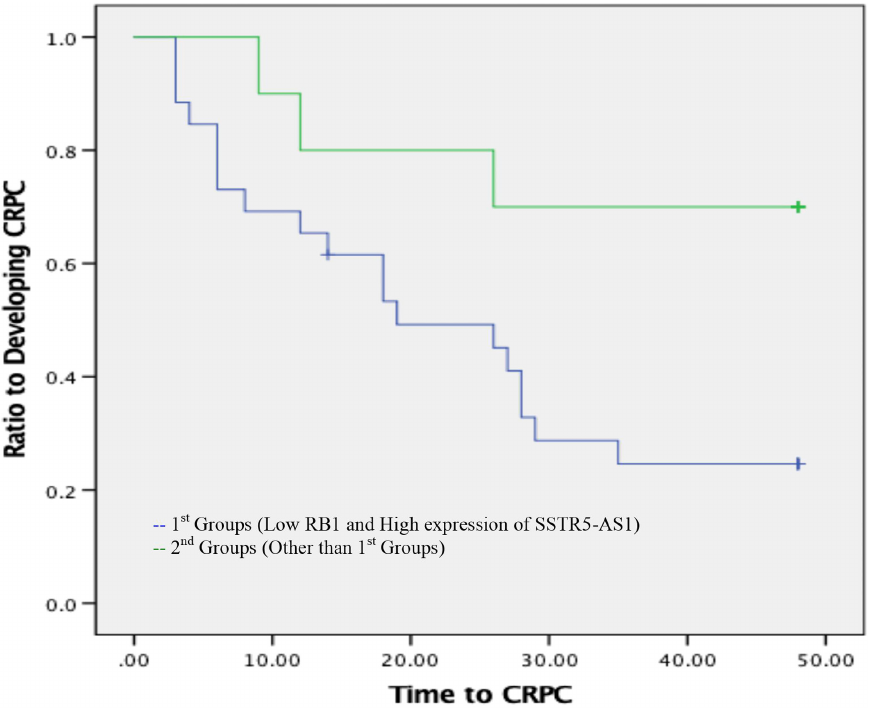
1. The expressions of SSTR5-AS1 (left) ( P > .05) and Rb1 (right) ( P < .001) on prostate cancer with no metastases and bone metastases at time of diagnoses ( P < .001).